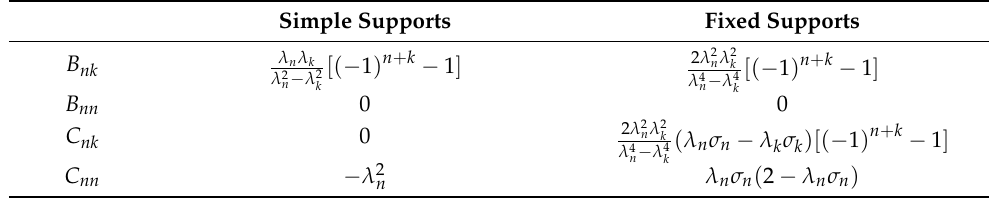
Table A1. The constants B nk and C nk . Simple Supports Fixed